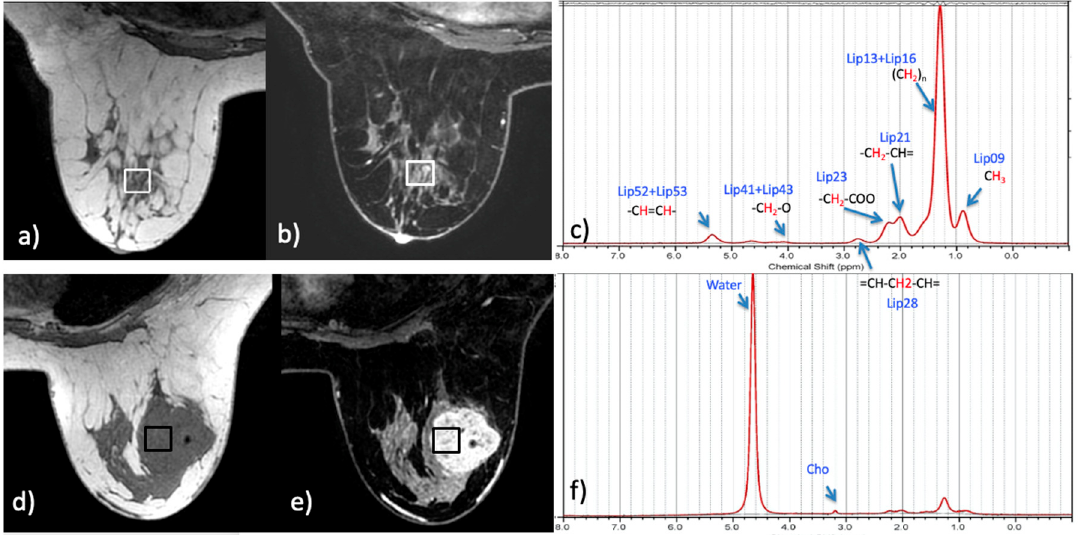
Figure 1. Example of magnetic resonance spectroscopy (MRS) voxel locations ( a ) and ( d ), T1 ‐ weighted fat ‐ unsuppressed image; ( b ) and ( e ), T1 ‐ weighted fat ‐ suppressed contrast ‐ enhanced image and their corresponding experimental spectra (black) overlaid with LCModel fit (red) ( c , f ), in normal fibroglandular tissue ( a , b , c ), and tumor tissue in a patient with invasive ductal carcinoma ( d , e , f ).